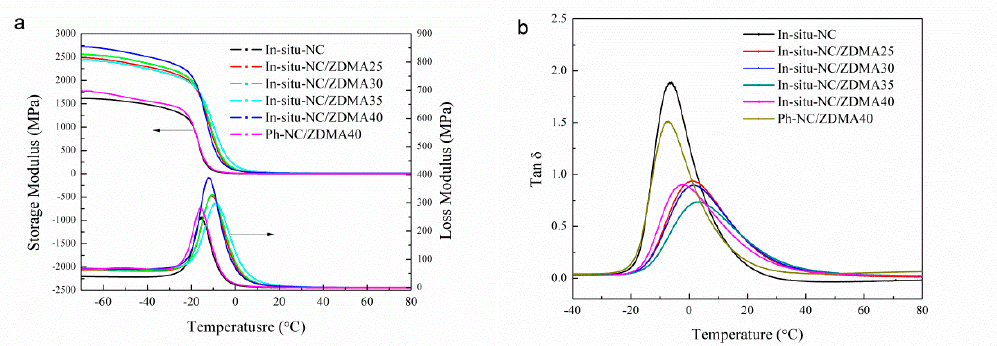
Figure 10. ( a ) Dependence of E ′ and E ″ and ( b ) tan δ versus temperature for in-situ-NC, in-situ-NC/ZDMAs and ph-NC/ZDMA40.